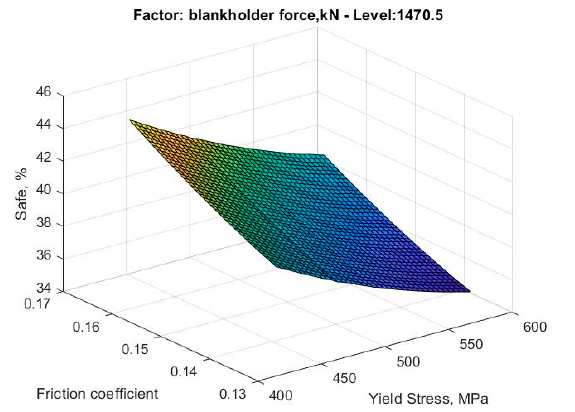
Figure 10. Metamodel of the percentage of area with insufficient stretching as friction coefficient and yield stress vary.